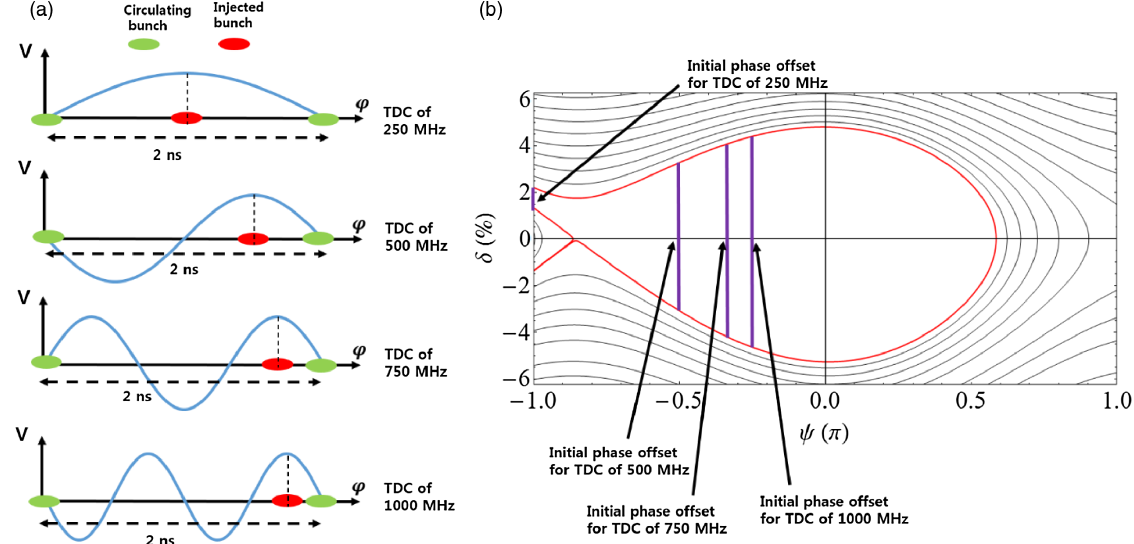
FIG. 1. (a) Working conditions along the rf frequency of the deflecting cavity. (b) Timing offset (phase offset) and energy acceptance of the injected beam along the rf frequency of the deflecting cavity. The energy acceptance at 750 MHz frequency is already close to the energy acceptance at synchrotron phase for an injected beam.